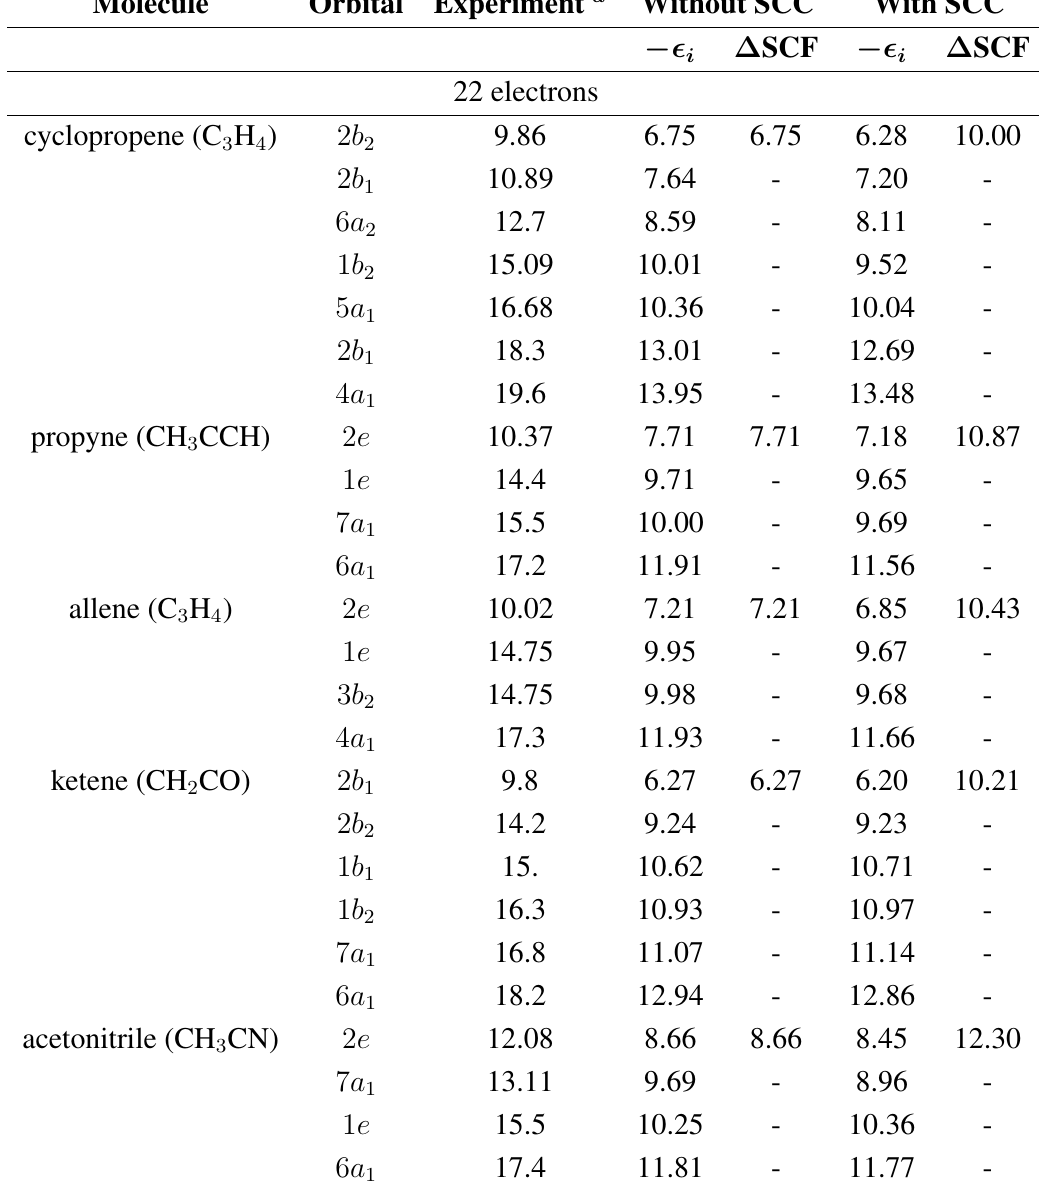
Table 2. DFTB+ IPs (eV) for small molecules